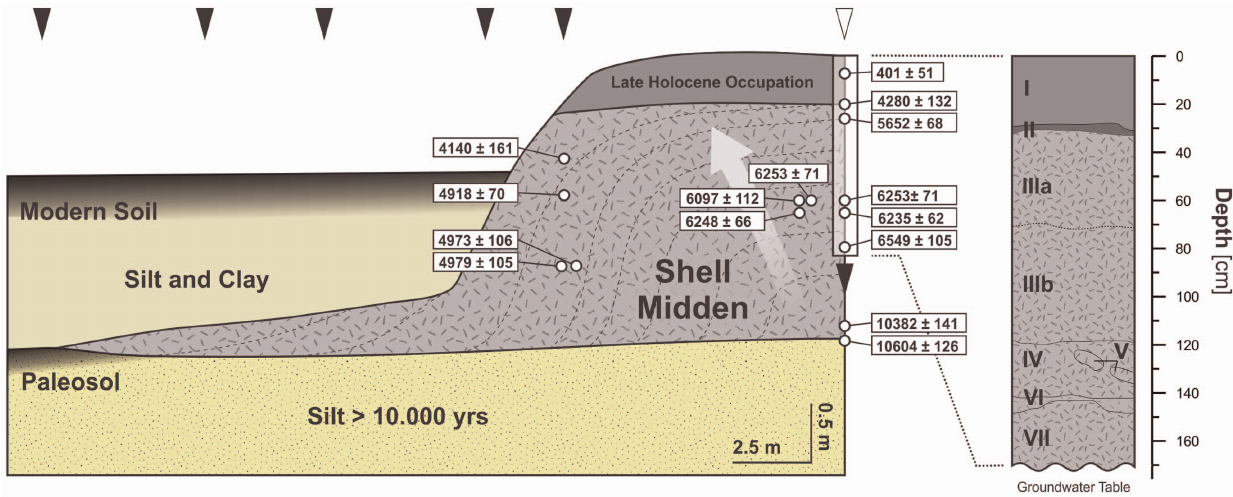
Figure 3. Cross-section transect of the shell midden SM1. Dashed lines and grey arrow highlight the onion-like growth of the midden reflected in the 14C dates. The black triangles above mark the coring locations and the white triangle the excavation site. The location of the transect and excavation is shown in Fig 1d.